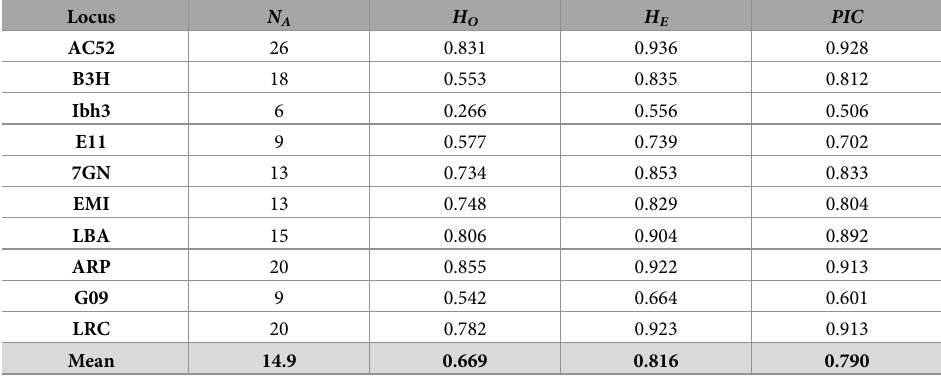
Table 2. Genetic diversity parameters of the 10 L . (V . ) braziliensis microsatellite loci. Locus